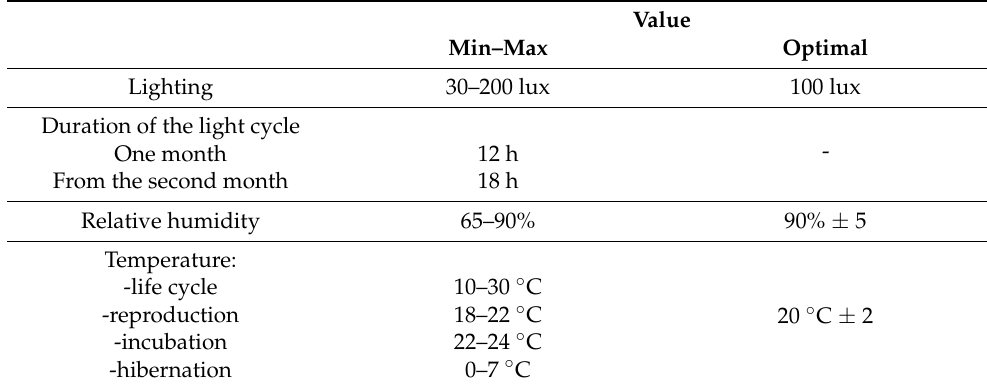
Table 3. Optimal conditions for snail rearing in a closed system